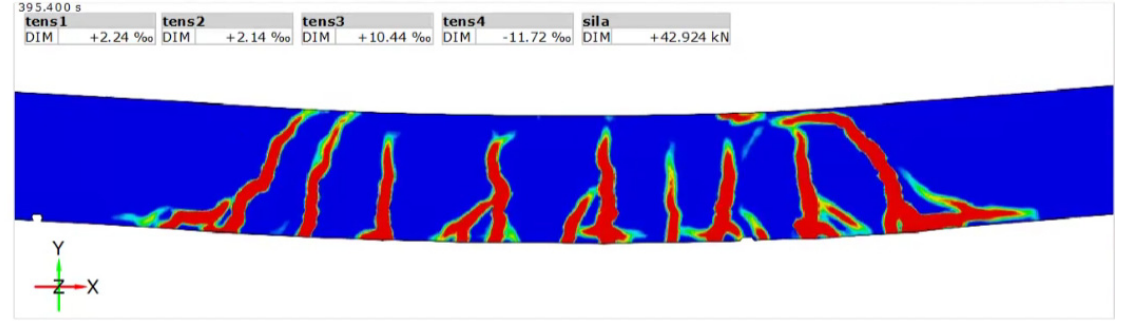
Figure 7. Measurement of cracks for K1 beam.